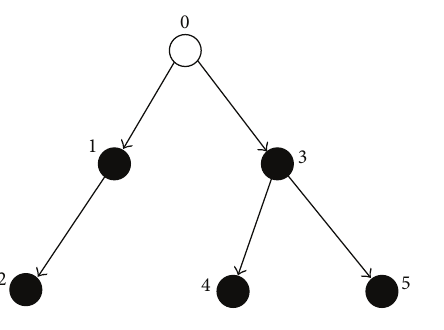
Figure 1: A spanning tree topology.